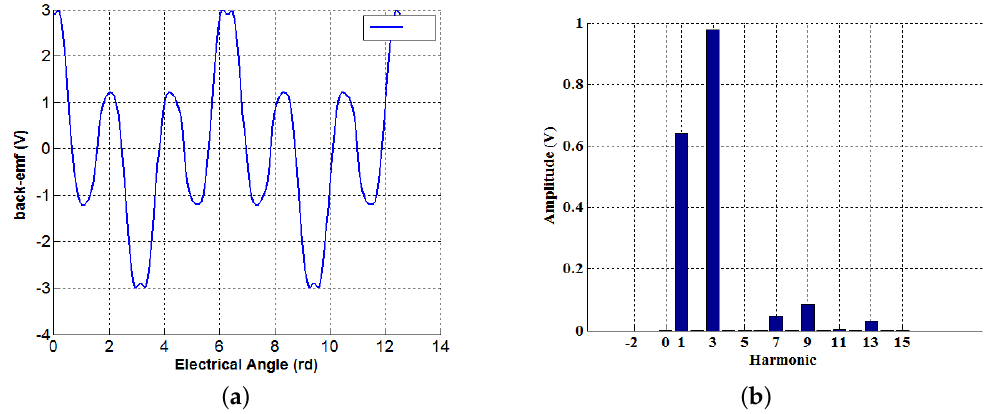
Figure 2. ( a ) Emf waveform of the bi-harmonic machine at 1000 rpm; ( b ) magnitude of the emf harmonics. Projections of the back-emfinto the two sub-spaces ( α 1 , β 1 ) and ( α 3 , β 3 ) are presented in Figure 3 over two electrical periods: